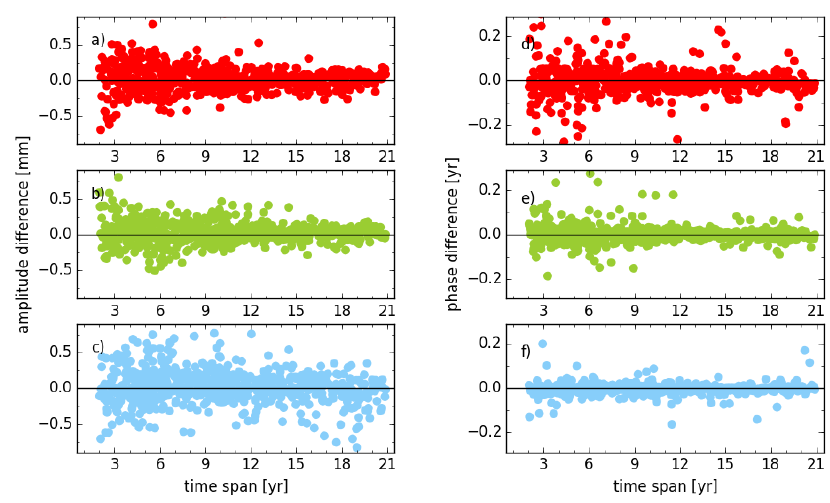
Figure 4. Amplitude and phase differences of annual signal between solution unit_tr_s2 and cova_tr_s2 for stations with different observation time spans; ( a , d ) for east; ( b , e ) for north; ( c , f ) for vertical components.